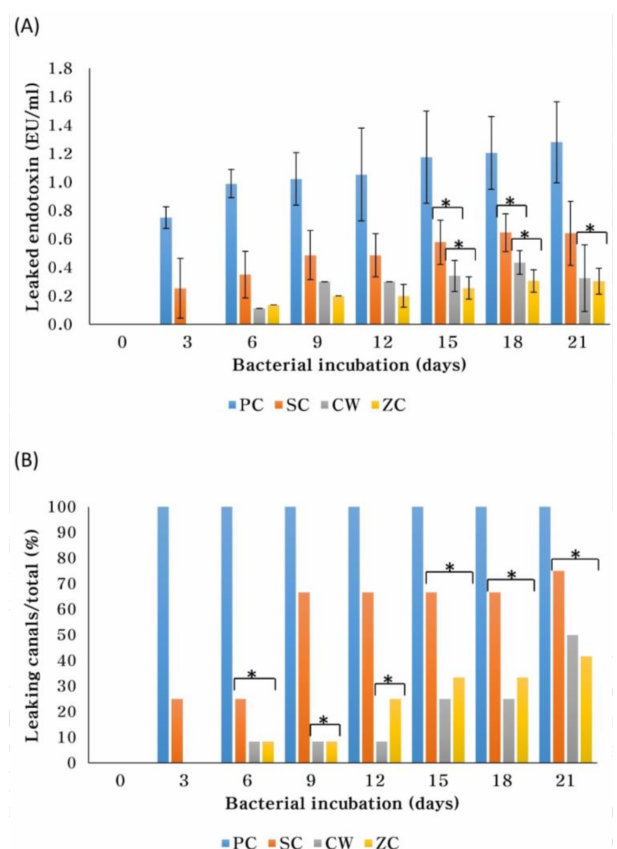
Figure 2. The amount (EU/mL) of endotoxin leakage ( A ) after 3, 6, 9, 12, 15, 18 and 21 days of bacterial incubation, and the ratio of root canals that leaked endotoxin ( B ). An asterisk (*) means no significant difference between groups. All negative control canals remained endotoxin-free for 21 days.